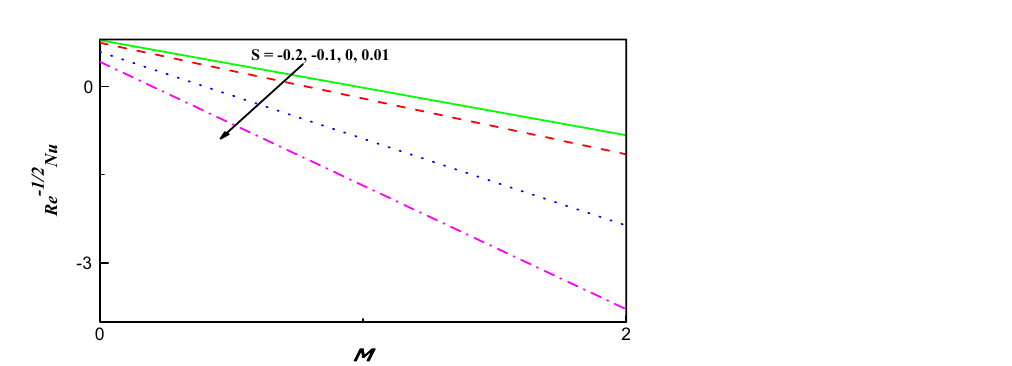
Figure 14. Re − 1 / 2 Nu Variation vs. M with S